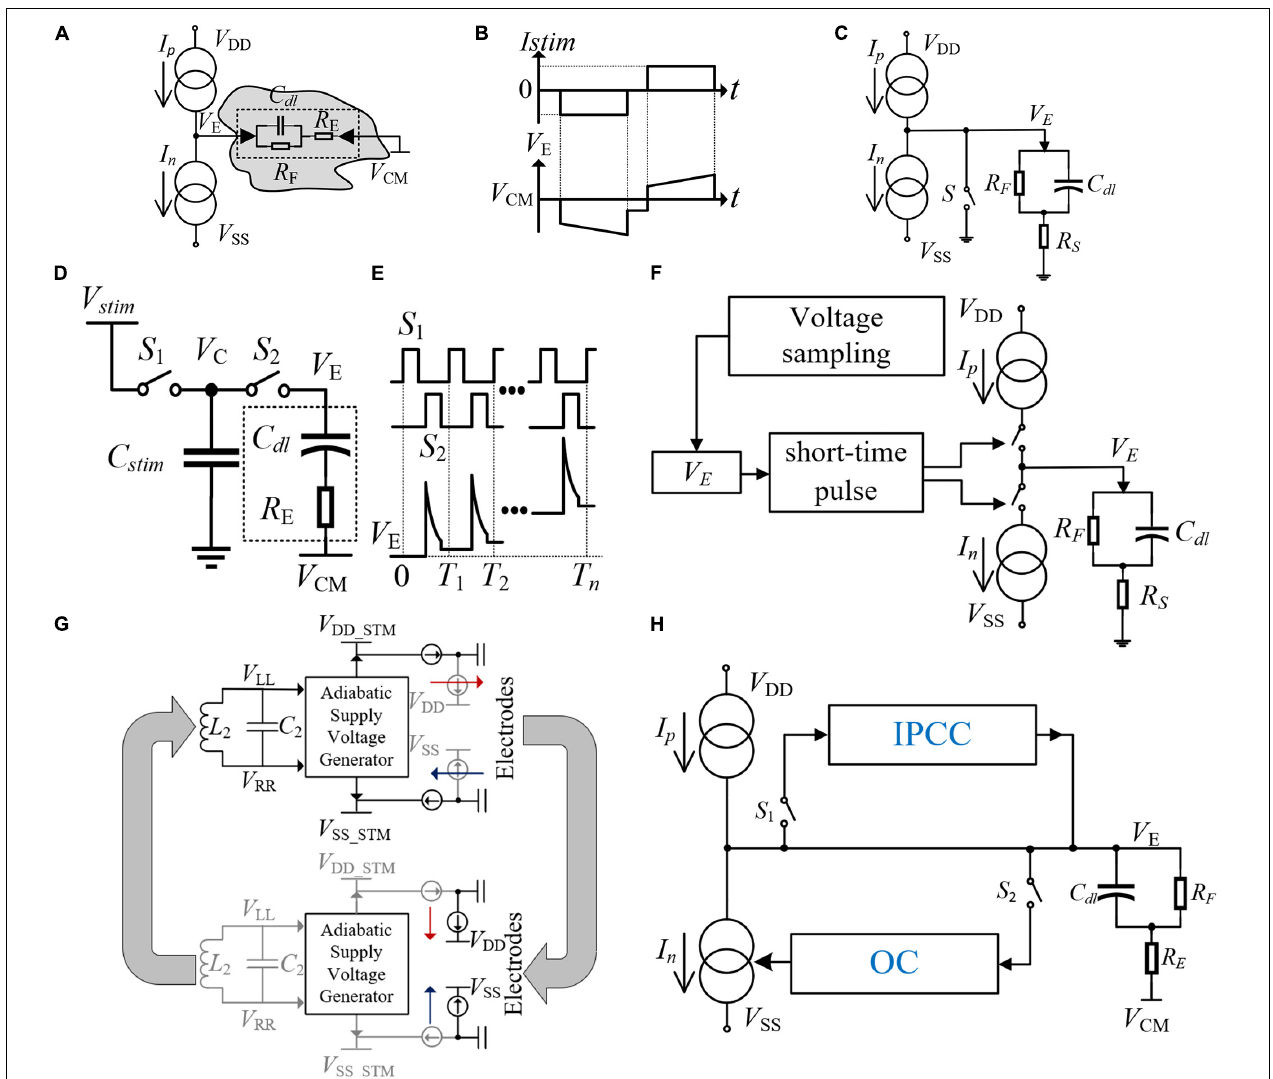
FIGURE 2 | (A) Traditional structure of a bidirectional current stimulator. (B) The current and voltage waveforms of the bidirectional current stimulator. (C) The structure of the stimulator with an electrode short-circuit technique. (D) The structure of the high-frequency switched-capacitor stimulator (HFSC). (E) The voltage waveform on the electrode with the switch control signals of the stimulator. (F) The structure of a stimulator using the short-time pulse insertion technique. (G) The structure of the adiabatic stimulator. (H) The structure of the stimulator with IPCC and